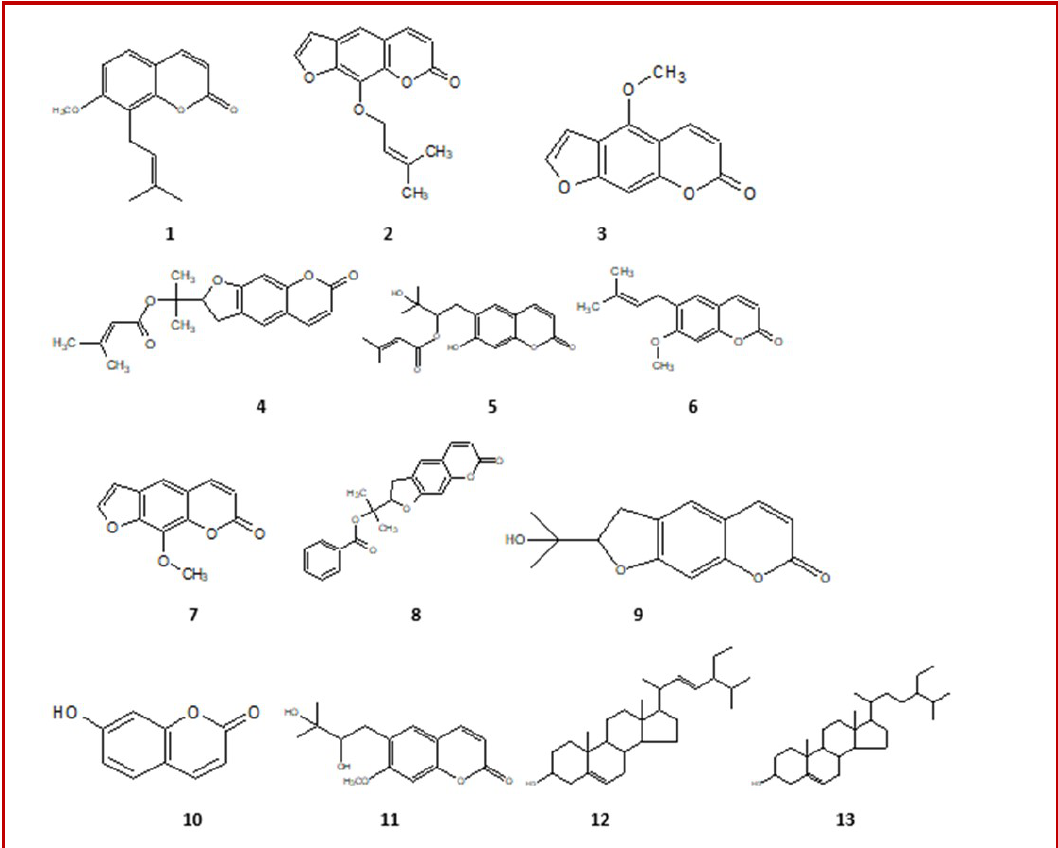
Figure 1: Chemical structures of compounds